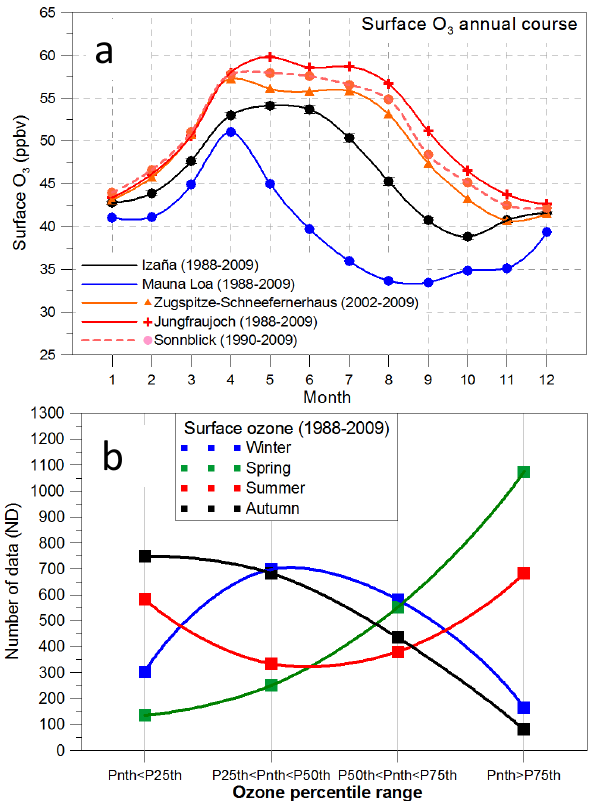
Fig. 4. (a) Annual course of surface O 3 at IZO, Mauna Loa, Fig. 4. (a) annual course of surface O 3 at IZO, Mauna-Loa, Zugspitze-Schneefernerhaus, Jungfraujoch, and Sonnblick. Bars Zugspitze-Schneefernerhaus, Jungfraujoch, and Sonnblick. Bars associated to monthly mean values at IZO are the standard devia- tion of the mean. (b) The seasonal distribution of number of surface associated to monthly mean values at IZO are the standard devia- O 3 daily data (ND) at IZO within the following percentile